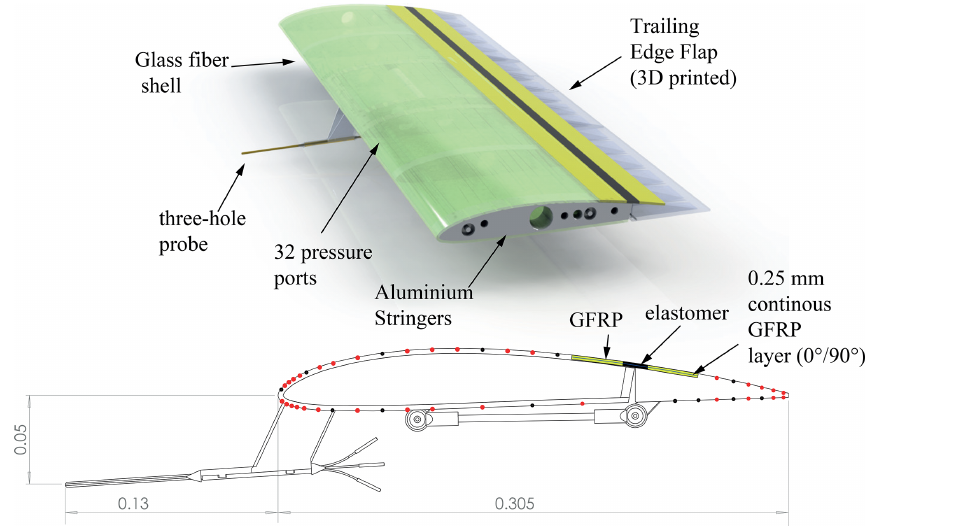
Figure 2. Sketch of the employed wing. Red dots on the surface indicate employed pressure ports; black dots show ports that were not used.